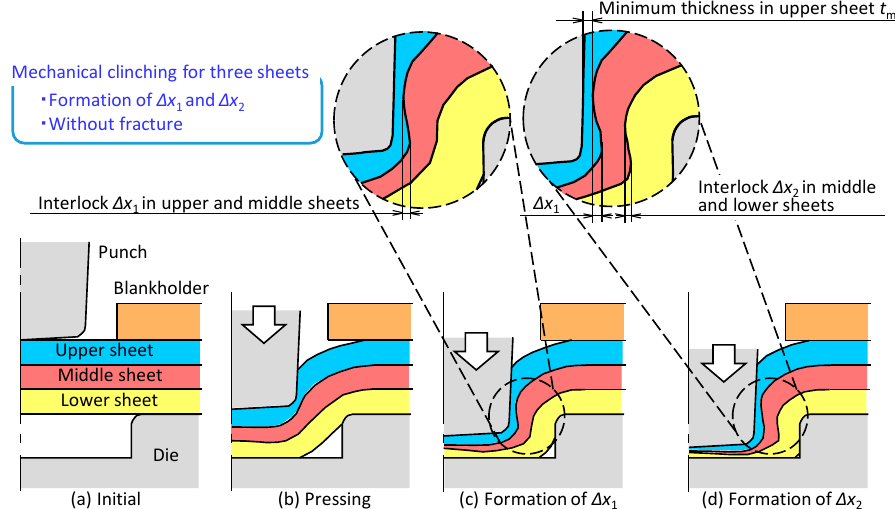
Figure 14. Mechanical clinching process of three sheets: ( a ) initial; ( b ) pressing; ( c ) formation of Δ x 1 ; ( d ) formation of Δ x 2 .